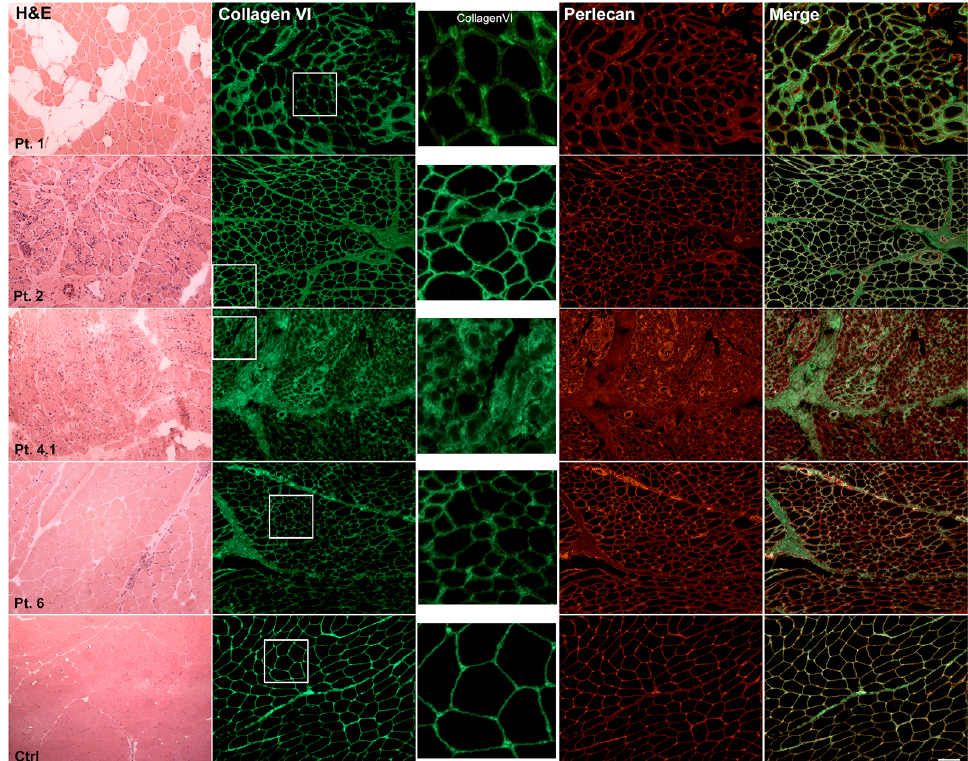
Figure 1. Histology and immunofluorescence on COL6 ‐ RM in pediatric patients. H&E staining showed marked fiber size variability, the presence of centronuclear fibers and a variable degree of fibrosis. Ctrl: aged ‐ matched control muscle biopsy. Scale bar: 50 μ m. Double fluorescent staining for collagen VI (green) and perlecan (red) showed an irregular membrane staining with a subtle signal reduction in Pts 1, 4.1 and 6 and a variable signal increase at perimysium in Pts 2 and 4.1. Pts 1 and 7.1 showed an enlargement between muscle fibers with collagen thickening. No patient showed a complete loss of collagen VI. The inset identifies the high magnification area. Scale bar: 50 µ m.